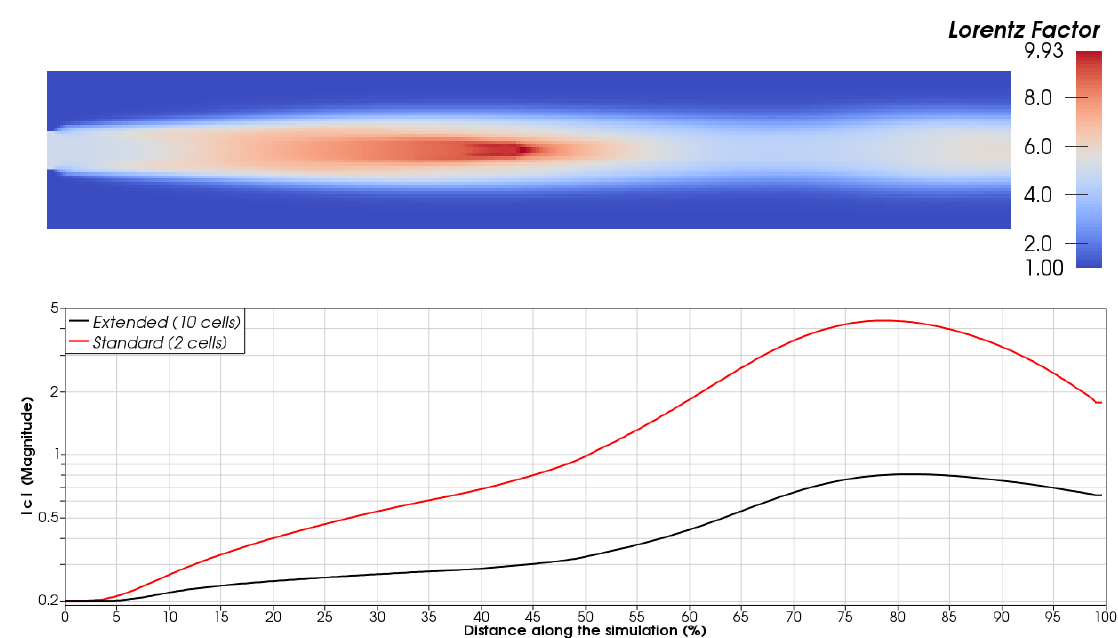
Figure 2. ( Top ) The cross-section of a recollimation shock in an over-pressured jet, and ( Bottom ) the jet-parallel vector component’s profile, along the jet axis, for standard ( z ≤ 2) and extended ( z ≤ 10) parallelepiped boundary